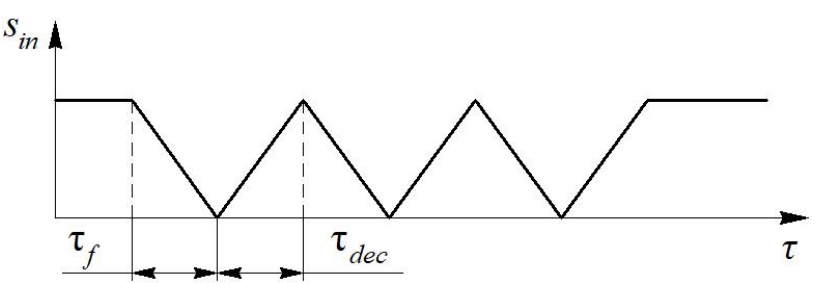
Figure 8. View of the input signal S in in time τ during dynamic calibration of the measuring system using a one–piece blade.